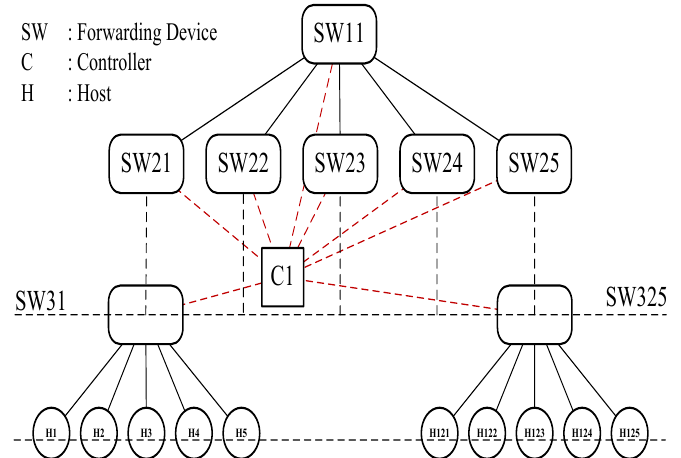
Figure 10. Network Scenario 3: Tree,3,5.